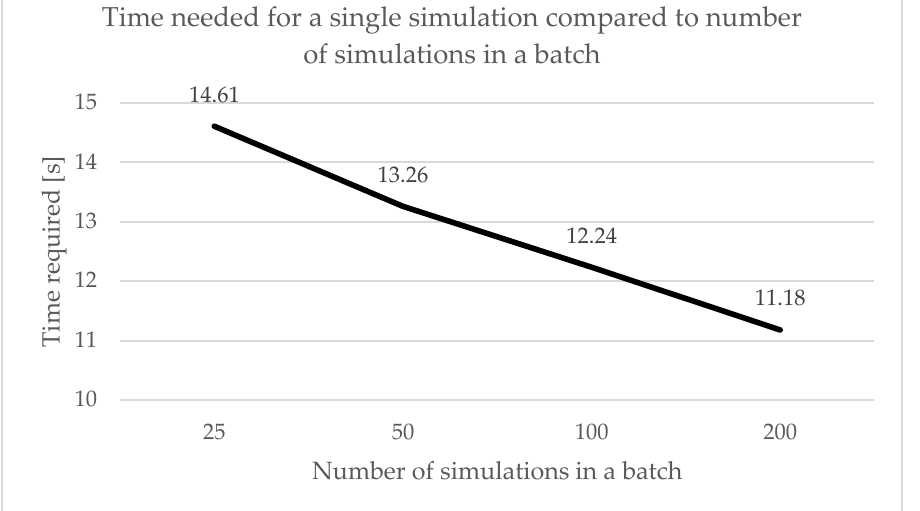
Figure 12. The time needed for a single simulation compared to the total number in a batch. Source: own.